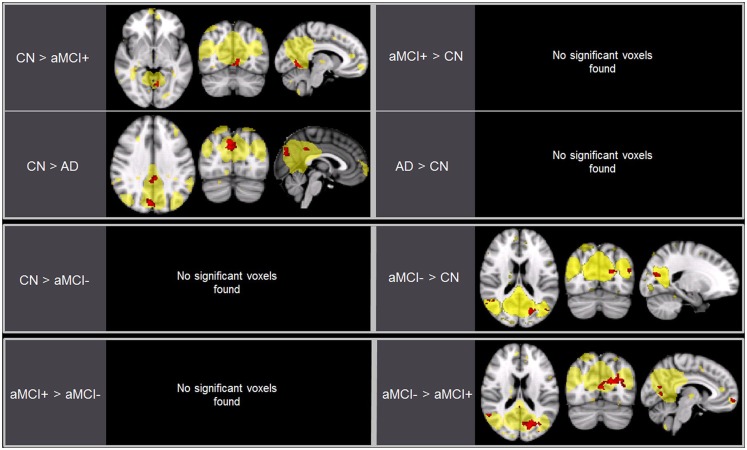
Brain regions displaying significant differences (in red) in the default mode network (DMN) between the groups using voxel-wise comparisons (p < 0.005, uncorrected for multiple comparisons) masked by the overall average DMN in yellow (p < 0.001, uncorrected). Results are superimposed on the MNI-152 T1 1-mm brain template.